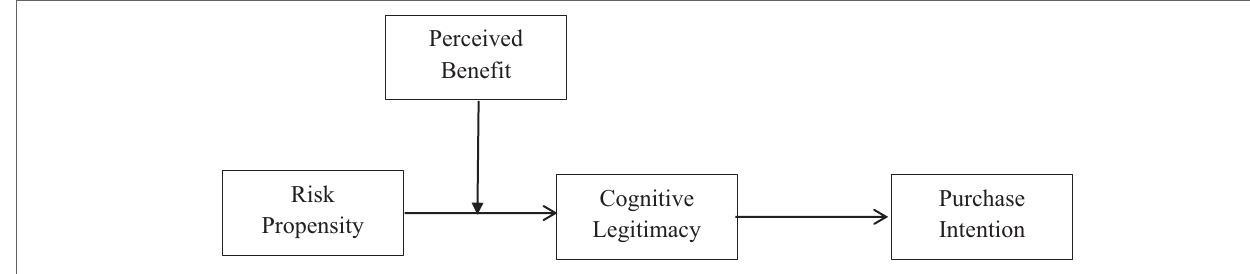
FIGURE 1 | Hypothesized model of processes linking risk propensity and purchase